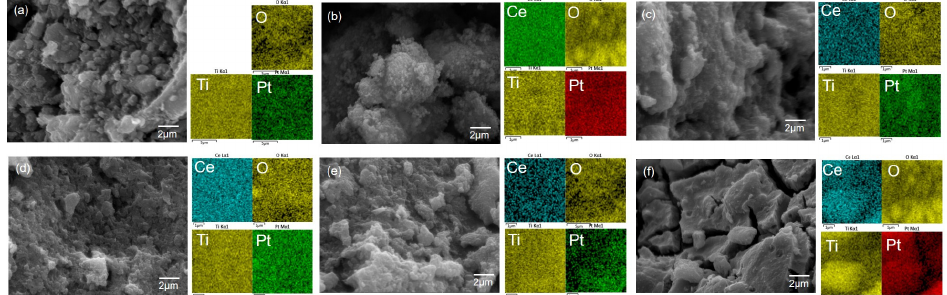
Figure 5. SEM images of Pt/Ce x Ti 1 − x O 2 catalysts: ( a ) Pt/TiO ( d ) Pt/Ce